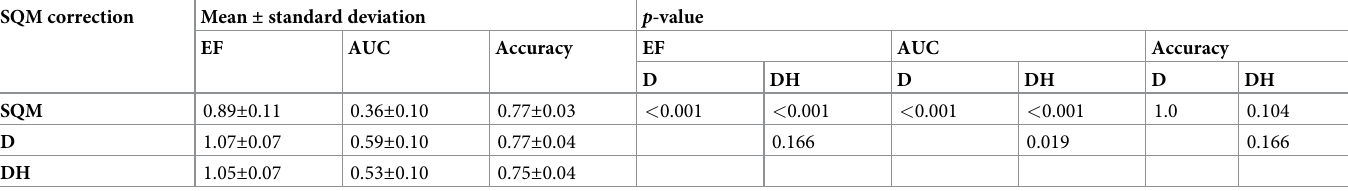
Table 4. Impact of SQM (semi-empirical quantum mechanics) corrections on the discerning ability of QM/MM-GMSA methods. SQM